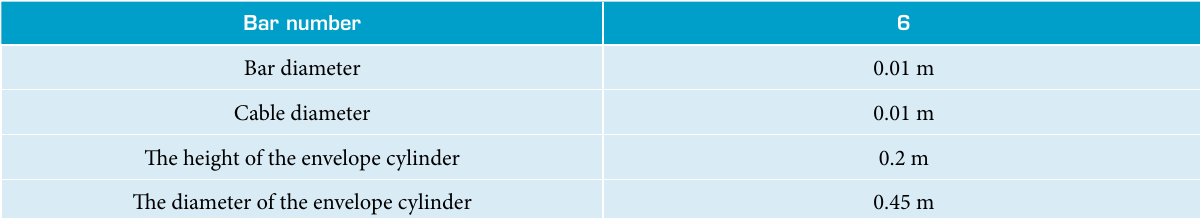
Figure 11. The development of the antenna. Table 2. Antenna structure